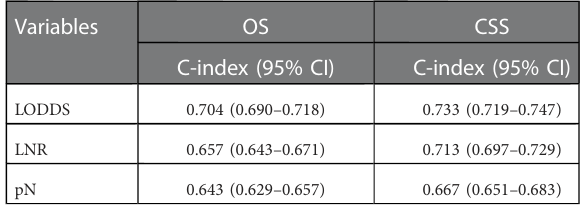
TABLE 3 Predictive capacity of pN stage, LNR, and LODDS in the OS and CSS of colorectal SRCC patients.